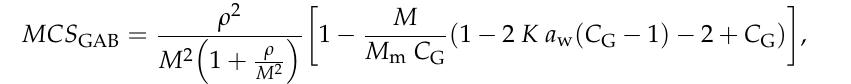
Figure 7. Water diffusivity as a function of water activity; filled circles (larva protein), unfilled squares (wheat gluten 80 °C, average values) [47] and filled squares (wheat gluten 120 °C, averages) [47].